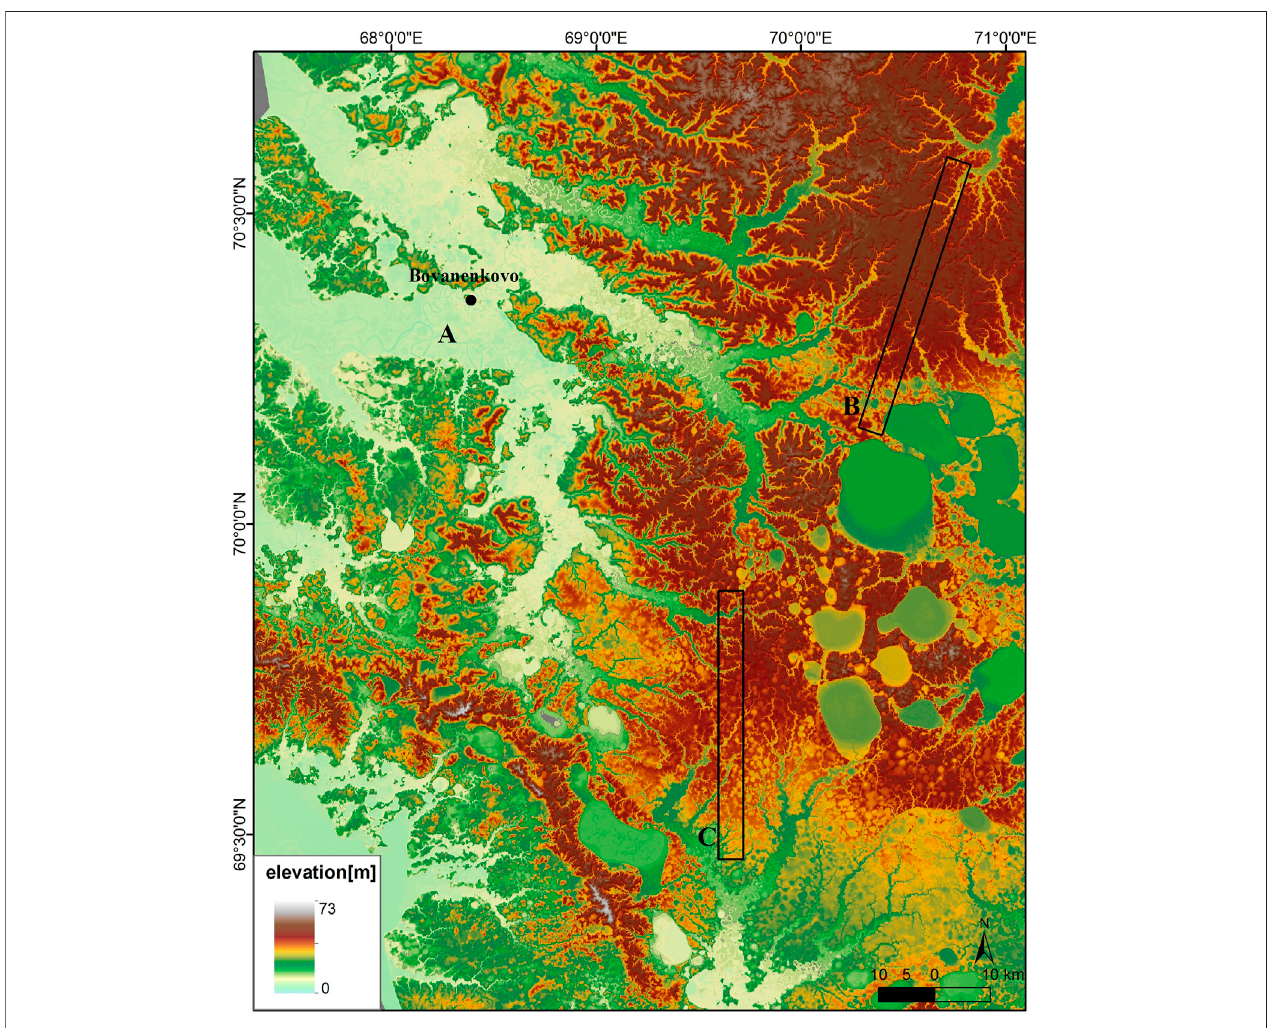
FIGURE 5 | TanDEM-X DEM elevation data 90 m resolution. The map shows the location of the subsiding zones (A,B) and (C) at different altitudes.